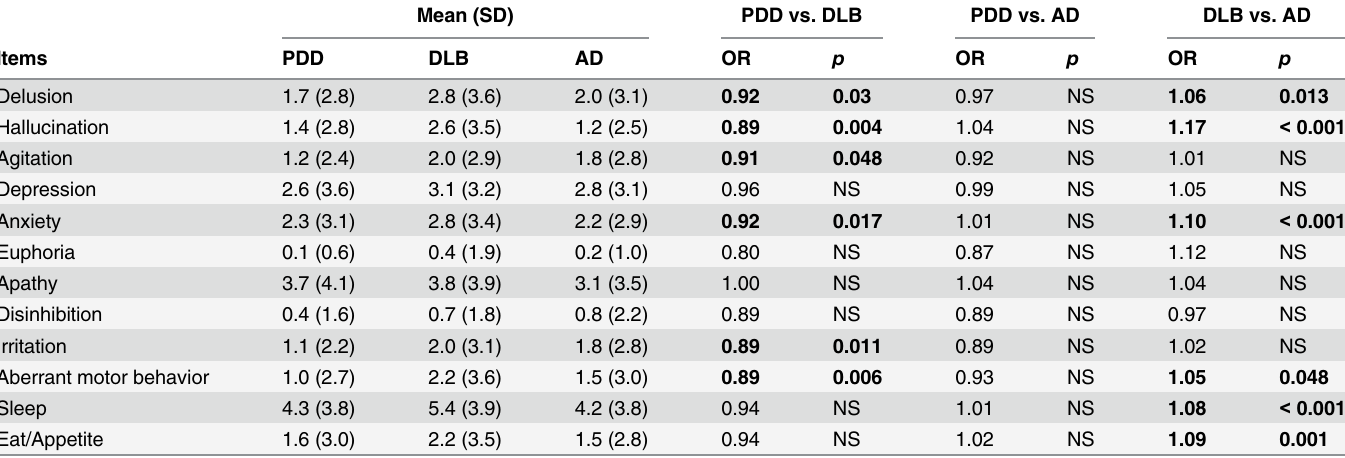
Table 2. Comparison of composite score (severity x frequency) of each item in the NPI among the PDD, DLB and AD groups adjusted for gender and use of antipsychotics. Mean (SD) PDD vs. DLB PDD vs. AD DLB vs. AD